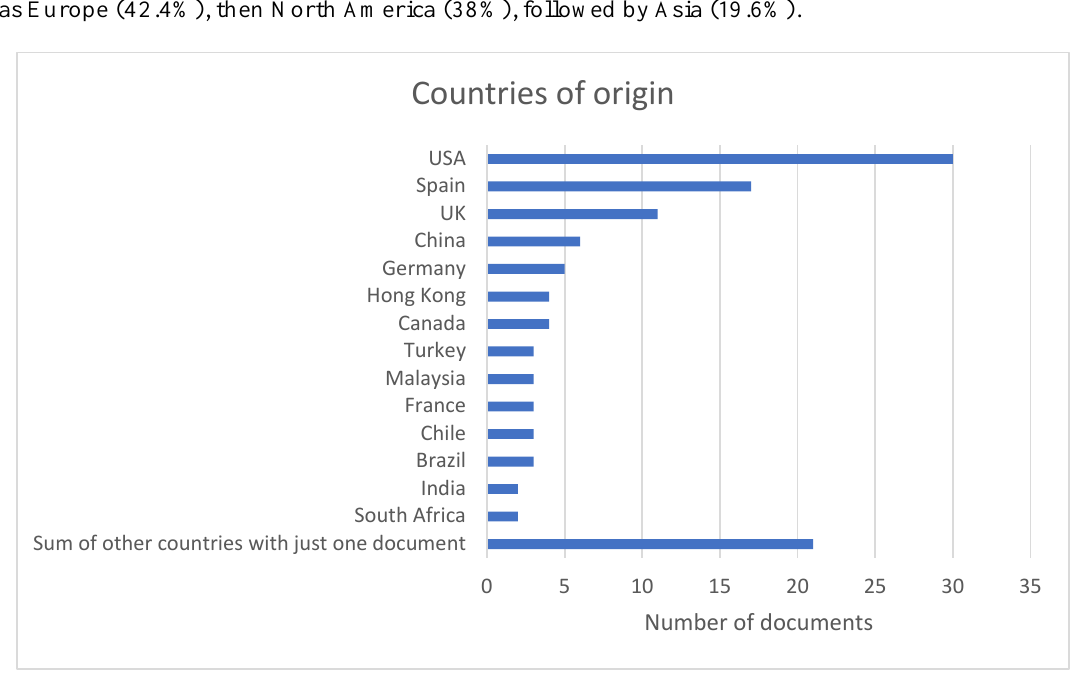
Figure 3. Authors’ affiliation and number of